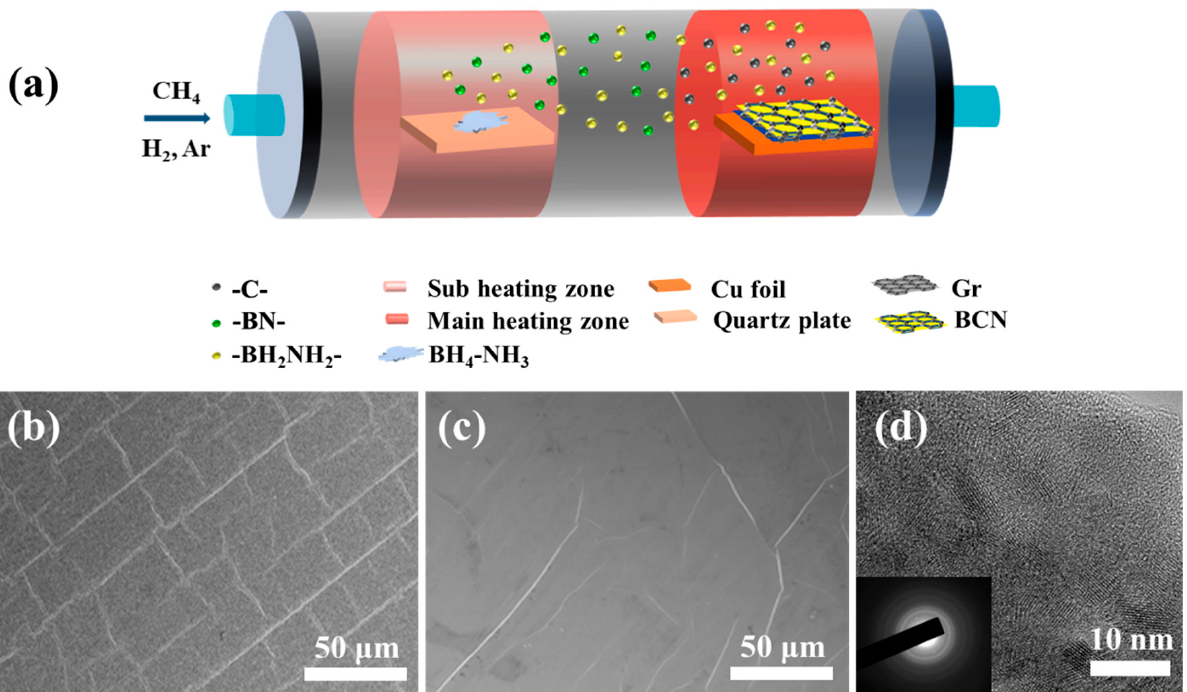
Figure 1. ( a ) Diagram of the home-built CVD furnace for the preparation of BCN and BCN/Gr; ( b ) SEM of the BCN two-dimensional film; ( c ) SEM of the BCN/Gr two-dimensional film; ( d ) TEM and electron diffraction pattern (inset) of the BCN/Gr two-dimensional film.